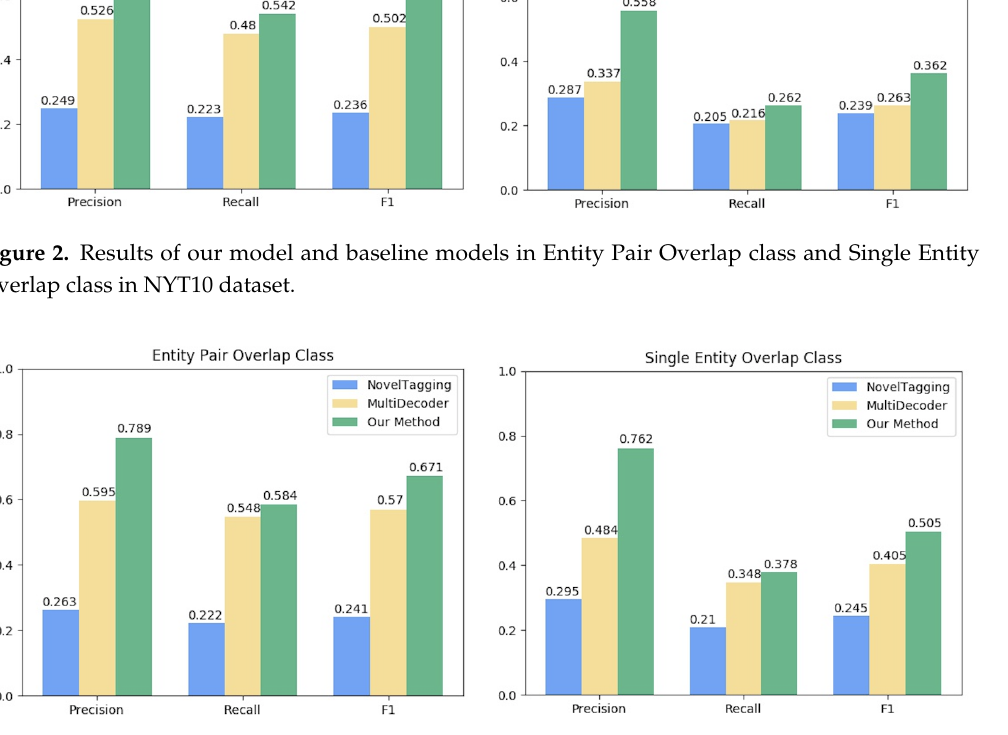
Figure 3. Results of our model and baseline models in Entity Pair Overlap class and Single Entity Overlap class in NYT11